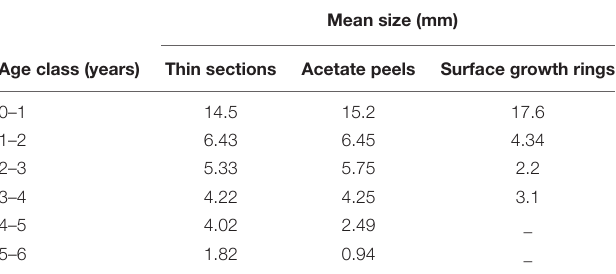
TABLE 2 | Mean annual growth rate calculated with the three aging techniques in the different age classes.